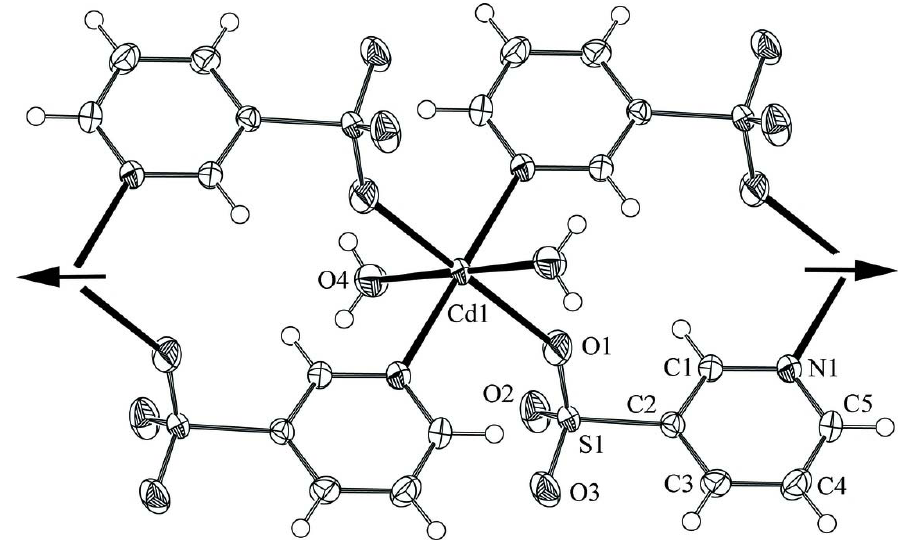
Figure 1 Extended structure in (I) showing the coordination geometry for the Cd atom, the atom labelling scheme and displacement ellipsoids at the 50% probability level. The Cd atom is located at a center of